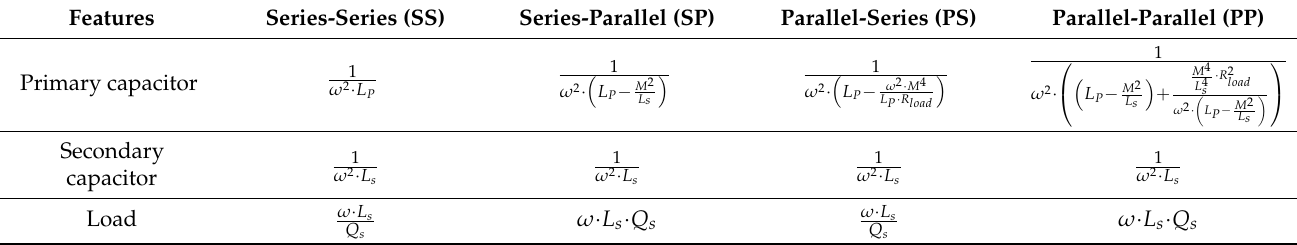
Table 1. Internal parameters of transmitter and receiver coils according to the compensation topology form.